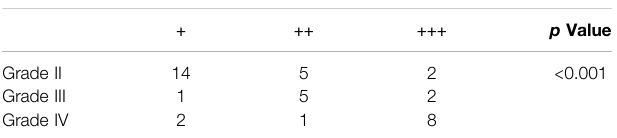
TABLE 2 | IHC score of CD74 in different grades of